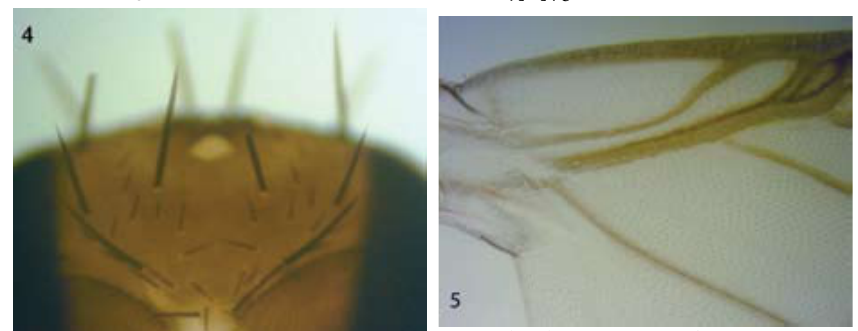
Fig. 5. Rhynchomicropteron nudiventer male, costal section 1.